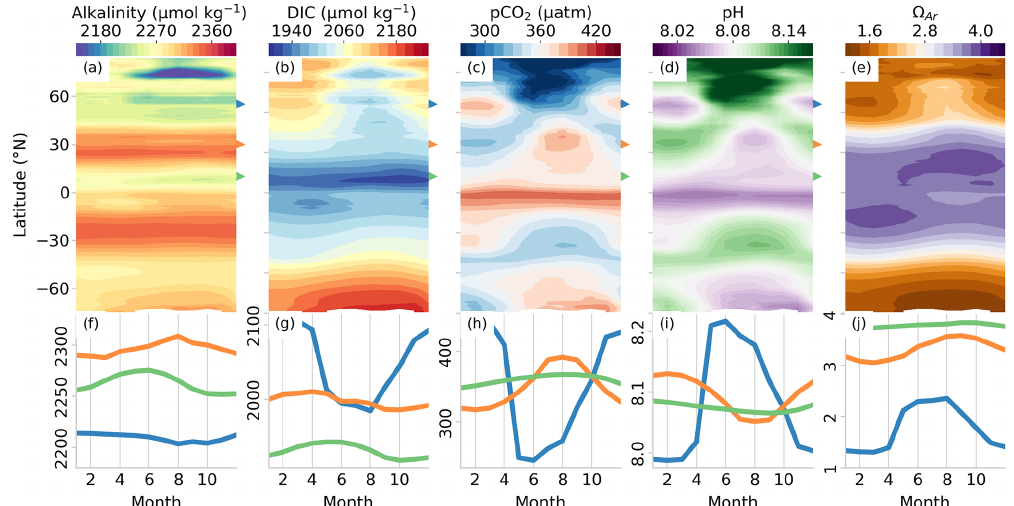
Figure 11. Hovmöller plots (a–e) showing the zonally averaged seasonal climatologies for (a) total alkalinity, (b) dissolved inorganic carbon, (c) p CO 2 , (d) pH, and (e) aragonite saturation state ( (cid:127) Ar ). The second row of panels (f) – (j) shows the corresponding variables for a high-latitude (55 ◦ N, 180 ◦ E, blue), midlatitude (30 ◦ N, 180 ◦ E, orange), and low-latitude (10 ◦ N, 180 ◦ E, green) locations. The units for panels (f) – (j) correspond with the units in panels (a) – (e) .